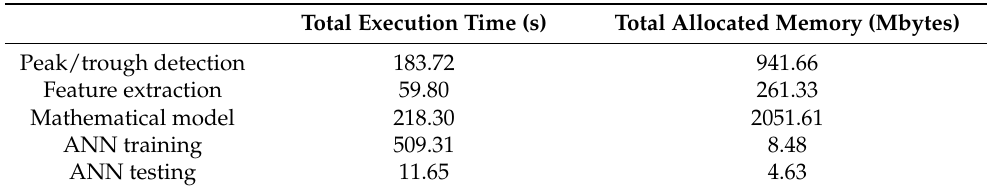
Table 2. Computational complexity based on execution time and memory allocation. The CPU clock speed during this process was 2.501 GHz. The execution time was measured with a precision of 1.00 × 10 − 7 s. The data for the peak/trough detection, feature extraction, and mathematical model are from a single sample file. These values are the same for both the training and test data. For ANN, the numbers correspond to a set of 30 measurements (our complete dataset). Total Execution Time (s) Total Allocated Memory (Mbytes) Peak/trough detection 183.72